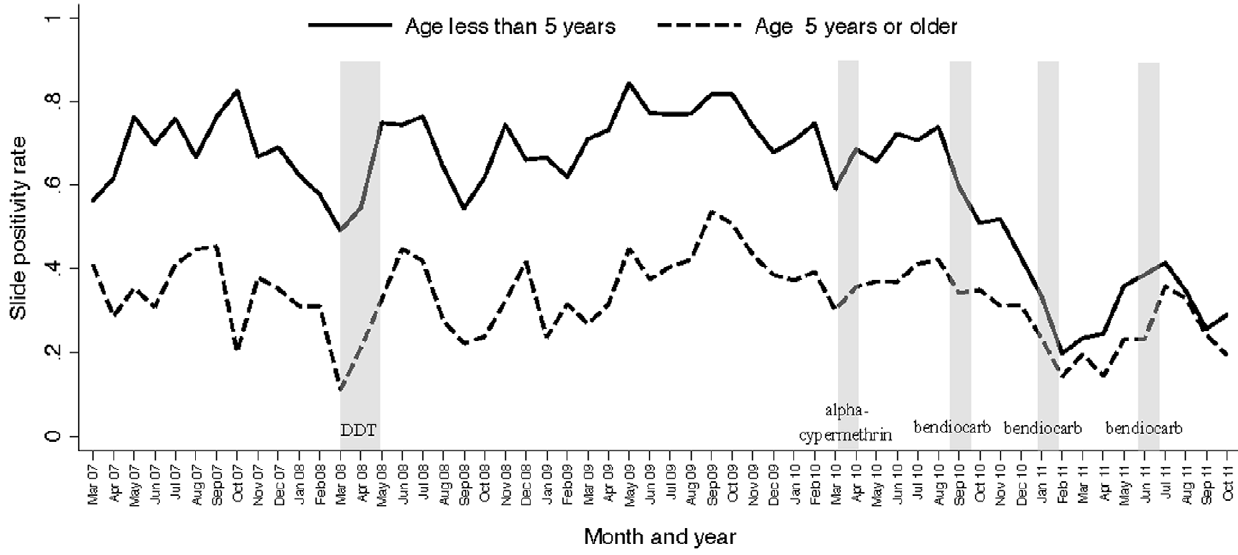
Figure 1. Monthly trends in malaria slide positivity stratified by age groups among patients with suspected malaria referred for laboratory testing at the Aduku Health Center in Apac, Uganda. Vertical bars represent the duration of each round of IRS.